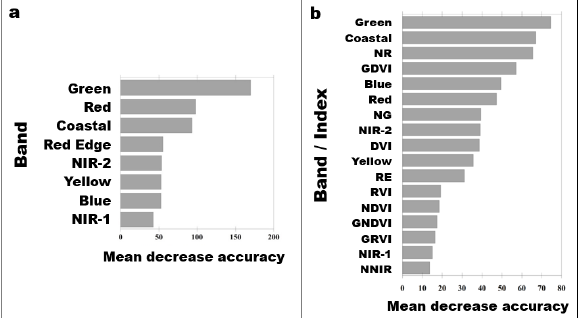
Figure 5. Variable importance plot computed by RF applied: a) to the eight original bands of the WV-2 image; b) the combination of the original 8-bands and the related vegetation indices.